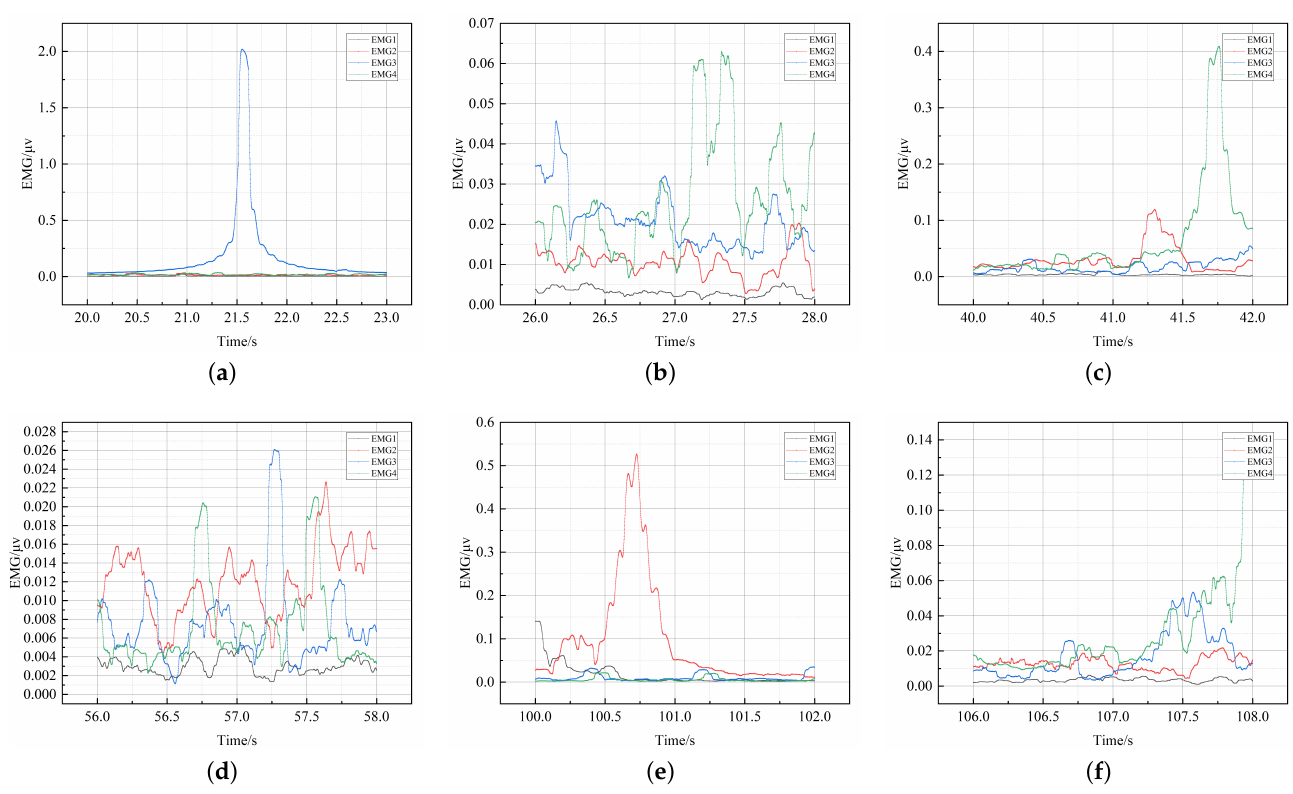
Figure 16. EMG data collection. The muscle contractions were collected from subjects using a smart sofa. ( a ) Stage1. ( b ) Stage2. ( c ) Stage3. ( d ) Stage4. ( e ) Stage5. ( f )